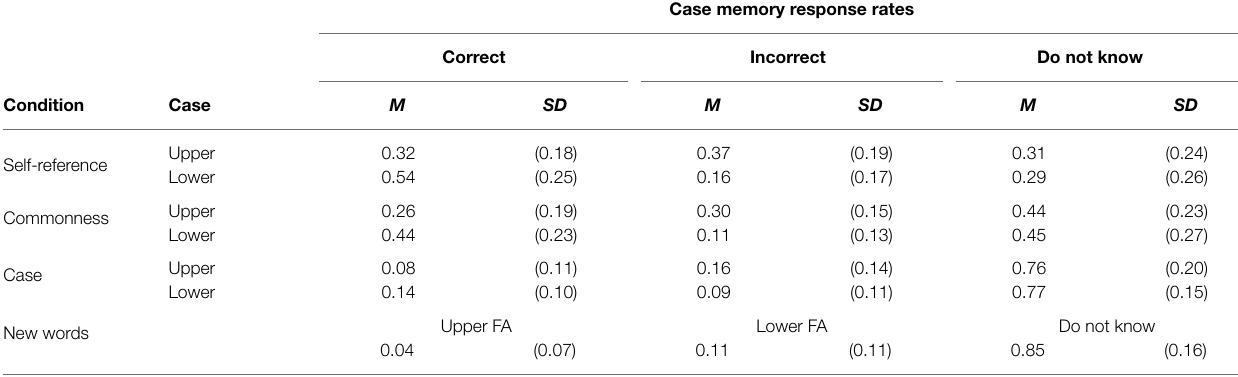
TABLE 3 | Case context memory (explicit